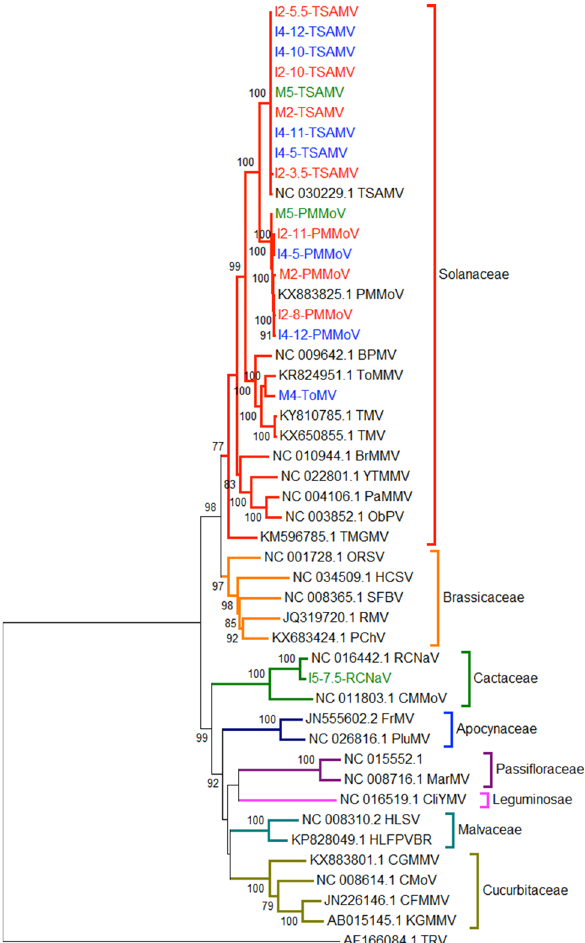
Figure 5. Phylogenetic tree of the complete Tobamovirus genomes (9 TSAMV, 6 PMMov, 1 ToMV and 1 RCNaV). On the right side, the plant family that serves as host for viruses in each clade is shown. The colors indicate the different children and mothers’ samples. Following the initial code, e.g., M2 for mother 2, and I2 for infant 2; the month at which the sample was collected is